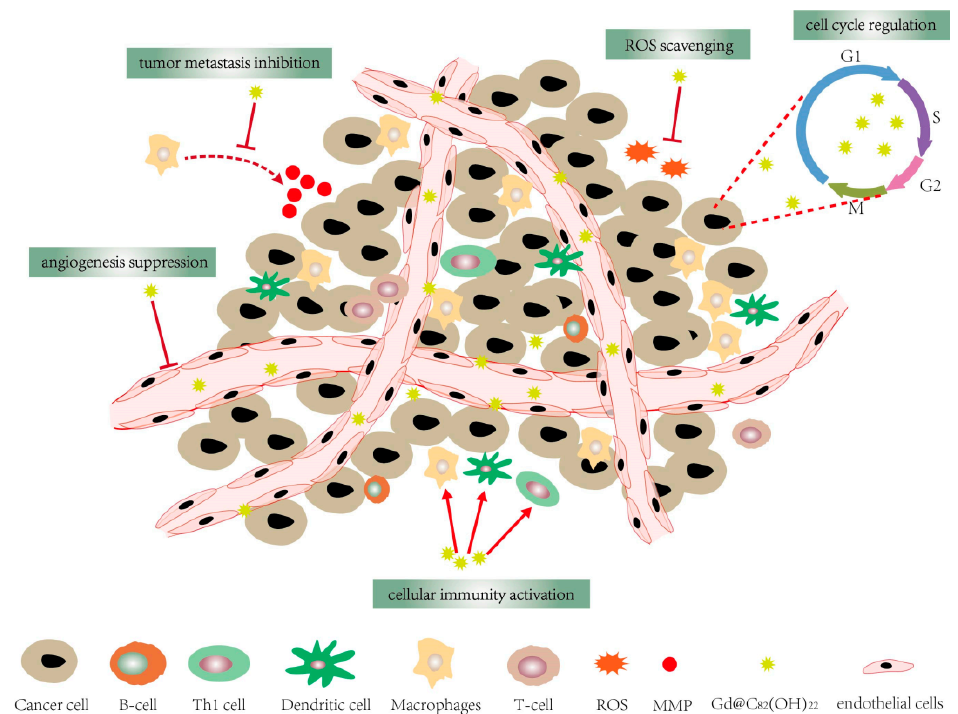
Figure 1. Gd@C 82 (OH) 22 has a variety of anti-tumor activities, including cellular immune activation, angiogenesis suppression, cell cycle regulation, tumor metastasis inhibition and ROS